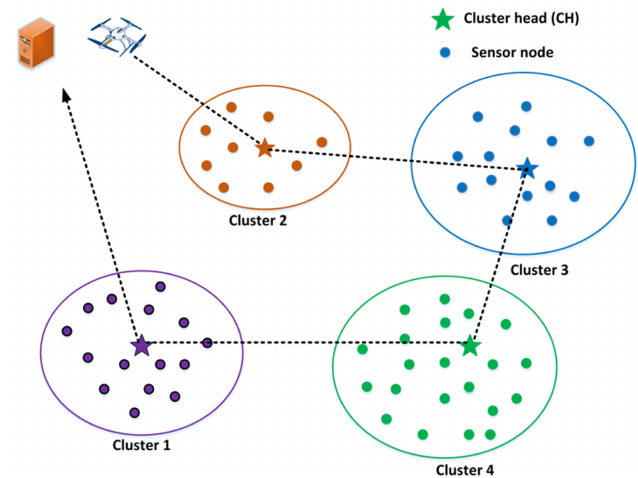
Figure 2. Data dissemination and gathering in a